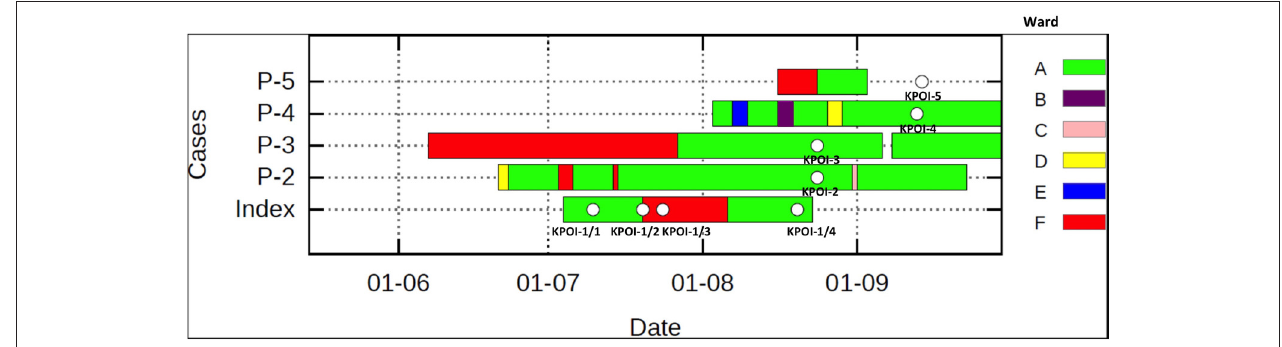
FIGURE 1 | Intra-hospital patient movements during the outbreak period. The white spot shown on the bar represents the sequenced isolate. Patient 5 (P-5) was sampled at home after being discharged from the hospital. Different wards are indicated by different colors.